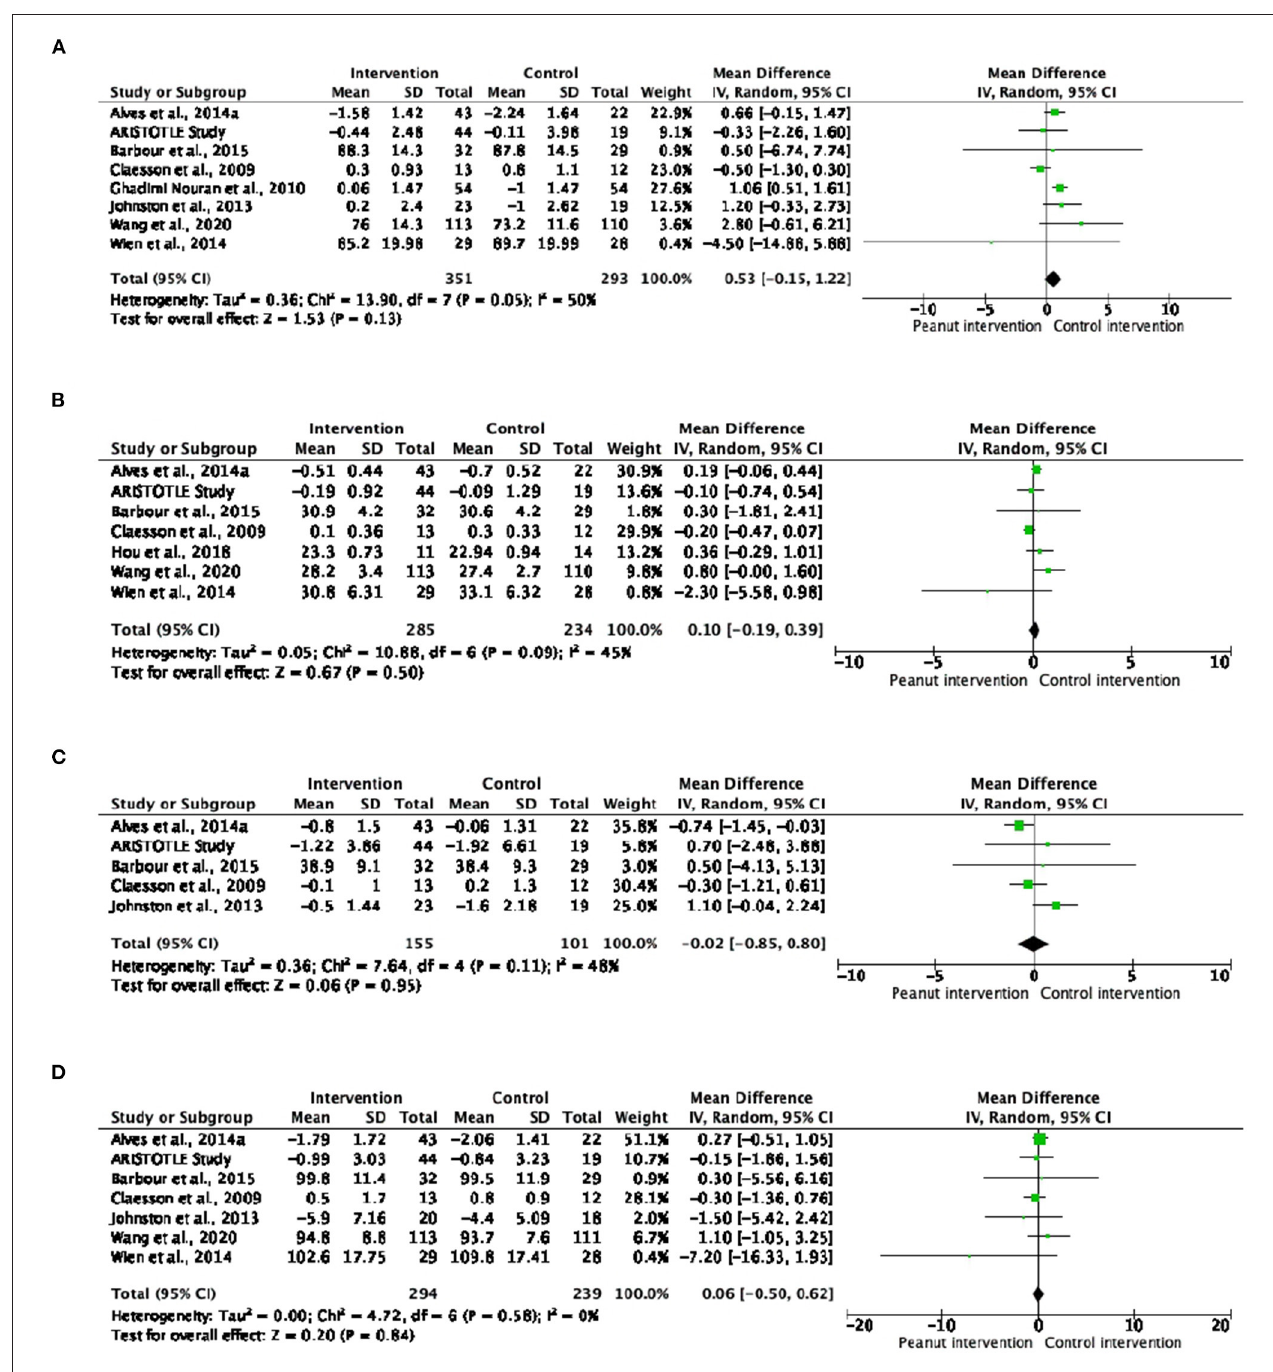
FIGURE 1 | Forest plot reporting mean differences for body weight (A) , body mass index (B) , body fat (C) and waist circumference (D) associated with peanut interventions compared to control interventions.